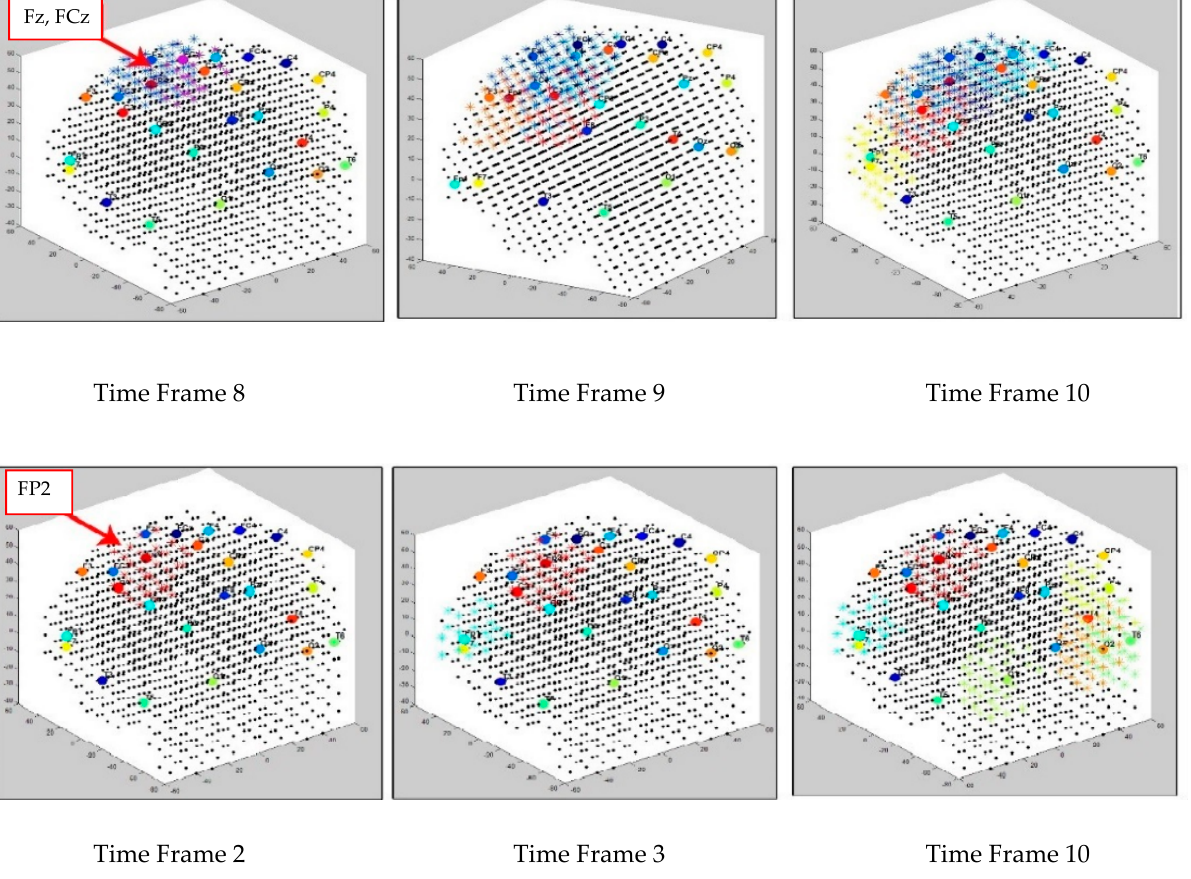
Figure 6. Three snapshots of the dynamic cluster creation process over time during the STDP learning in the SNN models of control (in the upper row ) and OP (in the lower row ).